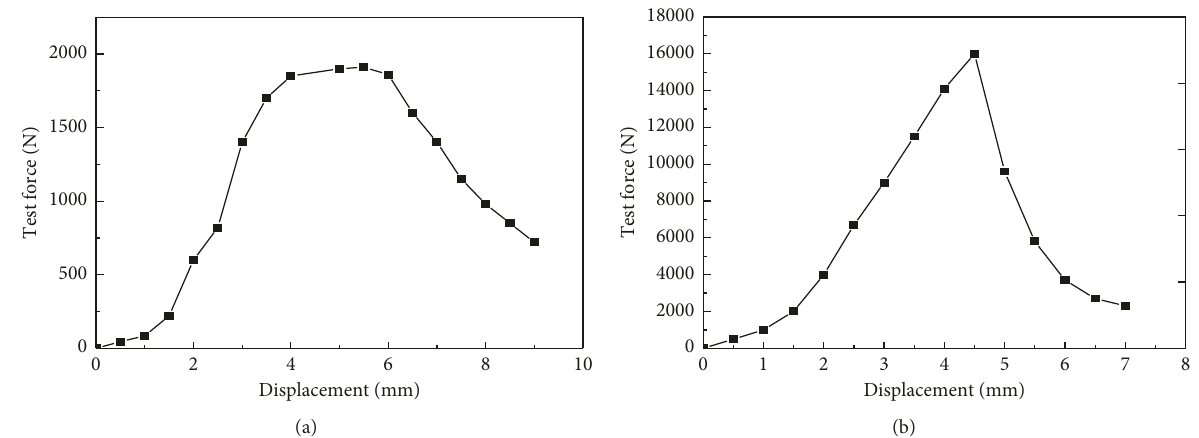
Figure 11: Comparison of test results from load-displacement curves. (a) Room temperature. (b) Low temperature.